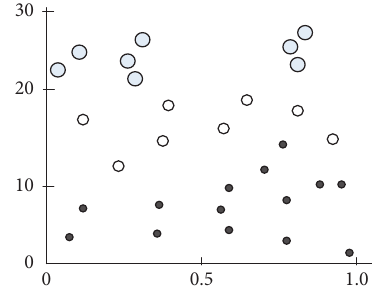
Figure 2: Population initialization with logistic mapping.